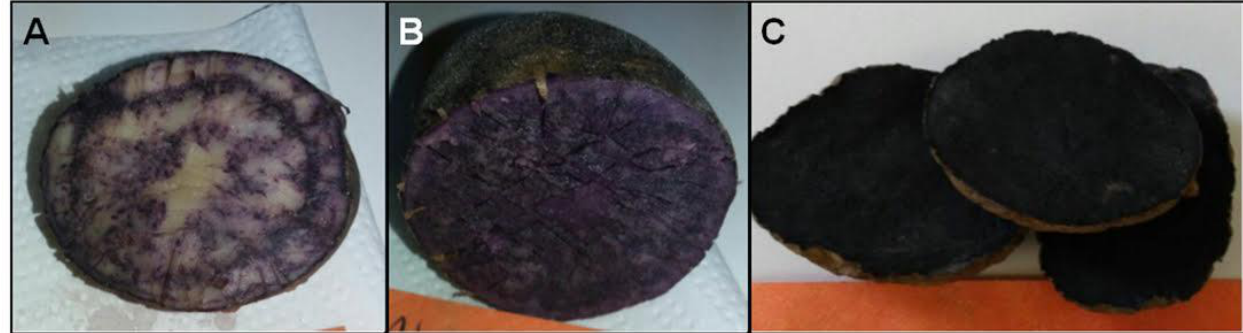
Figure 4. Some purple-fleshed potato genotypes were used in this study. ( A ) Low colored genotype CB2011.098. ( B ) Medium colored genotype CB2011.208. ( C ) High colored genotype CB2011.104.